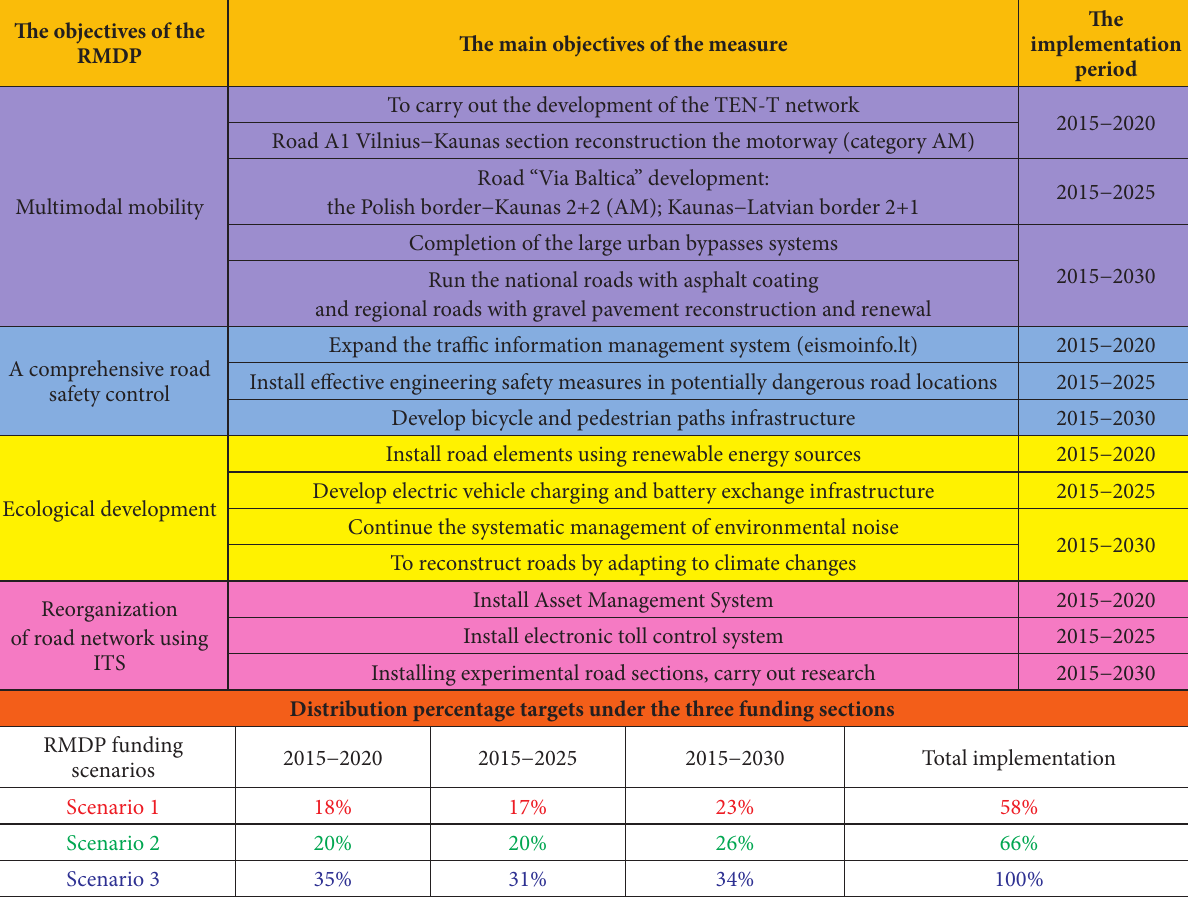
The objectives of the